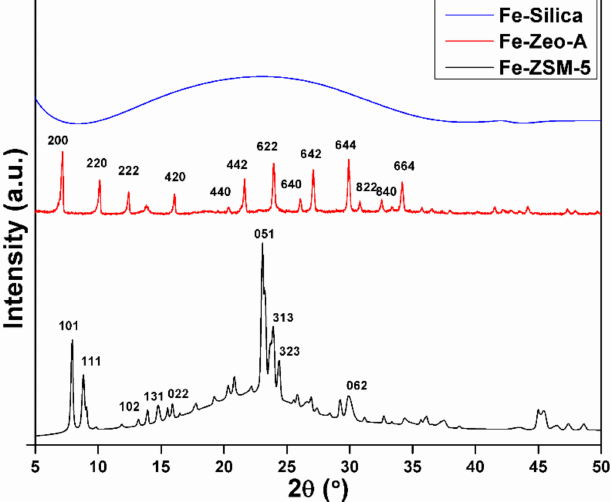
Figure 1. Scanning electron microscopy (SEM) images of Fe-ZSM-5, Fe-Zeo-A, and Fe-Silica.